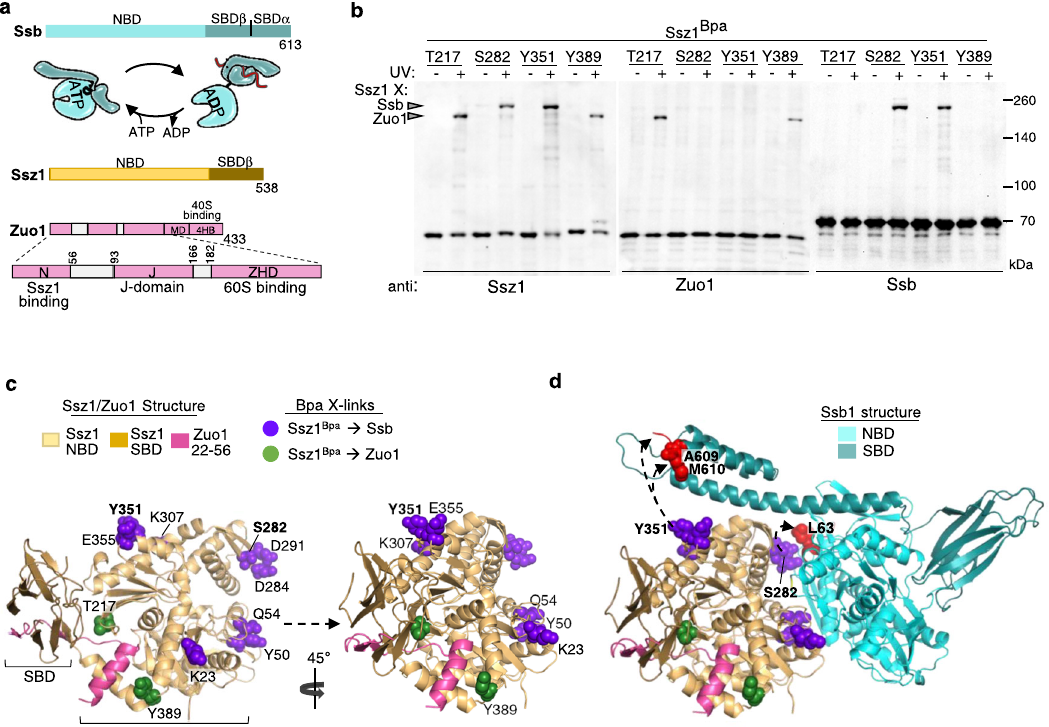
Fig. 1 The NBD of Ssz1 interacts with the NBD and SBD α of Ssb. a Schematic of triad components. Line diagrams denoting domains of canonical Hsp70 Ssb, atypical Hsp70 Ssz1 and J-domain protein Zuo1. Cartoon of ATP- and ADP-bound conformations of canonical Hsp70 Ssb1, with substrate bound in SBD β cleft of Hsp70(ADP) in red. Zuo1 line diagram expanded to emphasize segments functioning at 60 S ribosomal subunit. N domain (N); J-domain (J); Zuotin homology domain (ZHD); Middle domain (MD); 4-helix bundle (4HB). b Cross-linking of Ssz1 Bpa variants. Cells expressing Ssz1 variants with Bpa incorporated at indicated positions were exposed to UV light ( + ) or left unexposed ( − ). Cross-linking was analyzed by immunoblotting after SDS-PAGE using antibodies speci fi c for (anti) Ssz1, Zuo1, or Ssb, as indicated. Ssb and Zuo1 cross-link (X) products are indicated with arrowheads; migration of molecular weight markers (kDa) indicated by dashes. Uncropped blots are provided as a Source Data fi le. Three or more independent strains were analyzed for each Bpa variant, with similar results. c Model of Saccharomyces cerevisiae Ssz1 bound to residues 22 – 56 of Zuo1 based on the crystal structure of Chaetomium thermophilum proteins (PDB 5MB9). Ssz1 (NBD, beige; SBD, brown), Zuo1 (pink). Positions of Bpa in Ssz1 with identi fi ed cross-links shown in sphere representation: to Ssb (purple), to Zuo1 (dark green). See Supplementary Fig. 1 for Ssz1 variants tested. d Ssz1 – Ssb interaction. The top-ranked model from unbiased docking of Ssz1 and Ssb1 generated using the ZDOCK server starting with C. thermophilum Ssz1 (PDB 5MB9) and Ssb1 (PDB 5TKY) crystal structures, then fi t to S. cerevisiae sequences. Ssz1 is labeled as in ( c ); Ssb NBD, light teal; Ssb SBD dark teal. The peptides of puri fi ed Ssb1 that cross- linked to puri fi ed Ssz1 Bpa variants (positions labeled in bold) as determined by mass spectrometry are in red, with predominant cross-linked residues identi fi ed in sphere representation and labeled in bold: Ssz1 S282Bpa to Ssb1 L63; Ssz1 Y351Bpa to the C terminus of Ssb1, predominately A609, M610, and the peptide backbone at the extreme C-terminus. See Table 1 and Supplementary Figs. 2, 3 for further information. Table 1 Analysis of Ssz1 S282Bpa and Ssz1 Y351Bpa crosslinks to Ssb1 a . Ssz1 Bpa Ssz1 Bpa peptide d Ssb1 peptide d